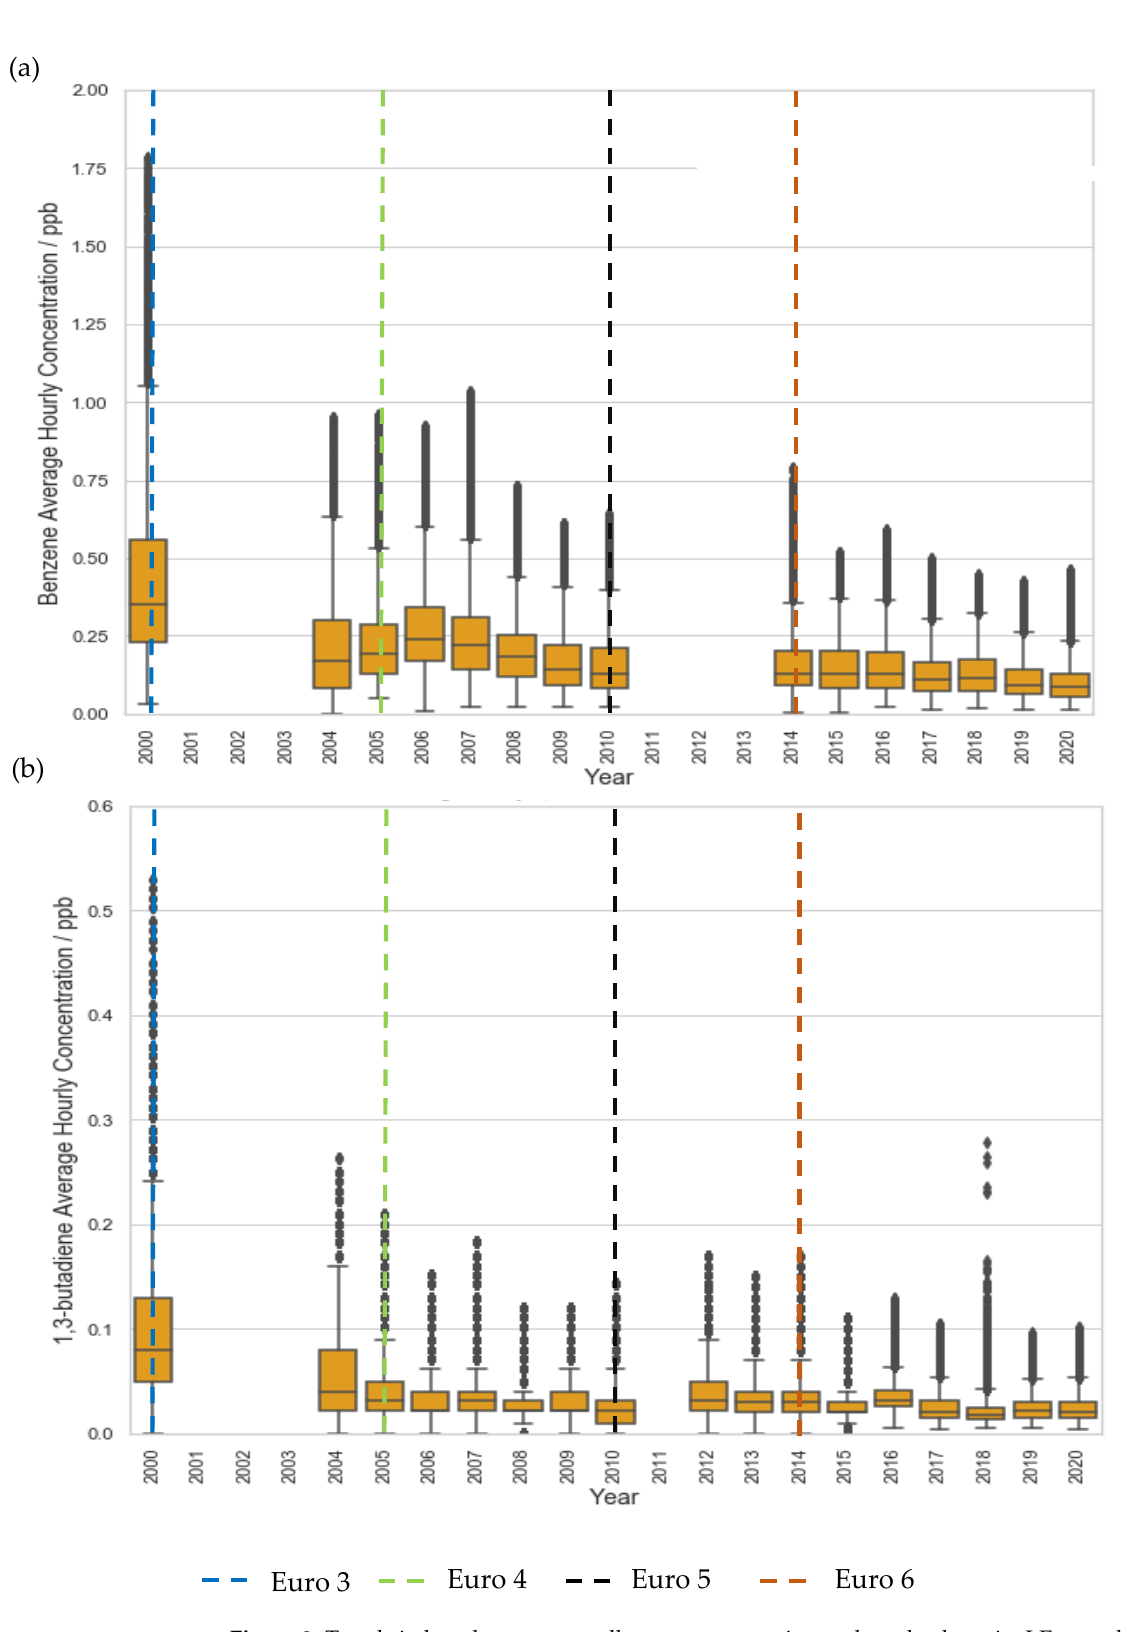
Figure 2. Trends in hourly-average pollutant concentration at the suburban site LE over the period 2000–2020, ( a ) benzene and ( b ) 1,3 butadiene. Error bars represent the 95% confidence level in pollutant concentration. Vertical lines represent implementation year of each relevant Euro control. Years with data coverage below 70% were omitted from analysis to avoid seasonal skewing (see Appendix A for data coverage representation).